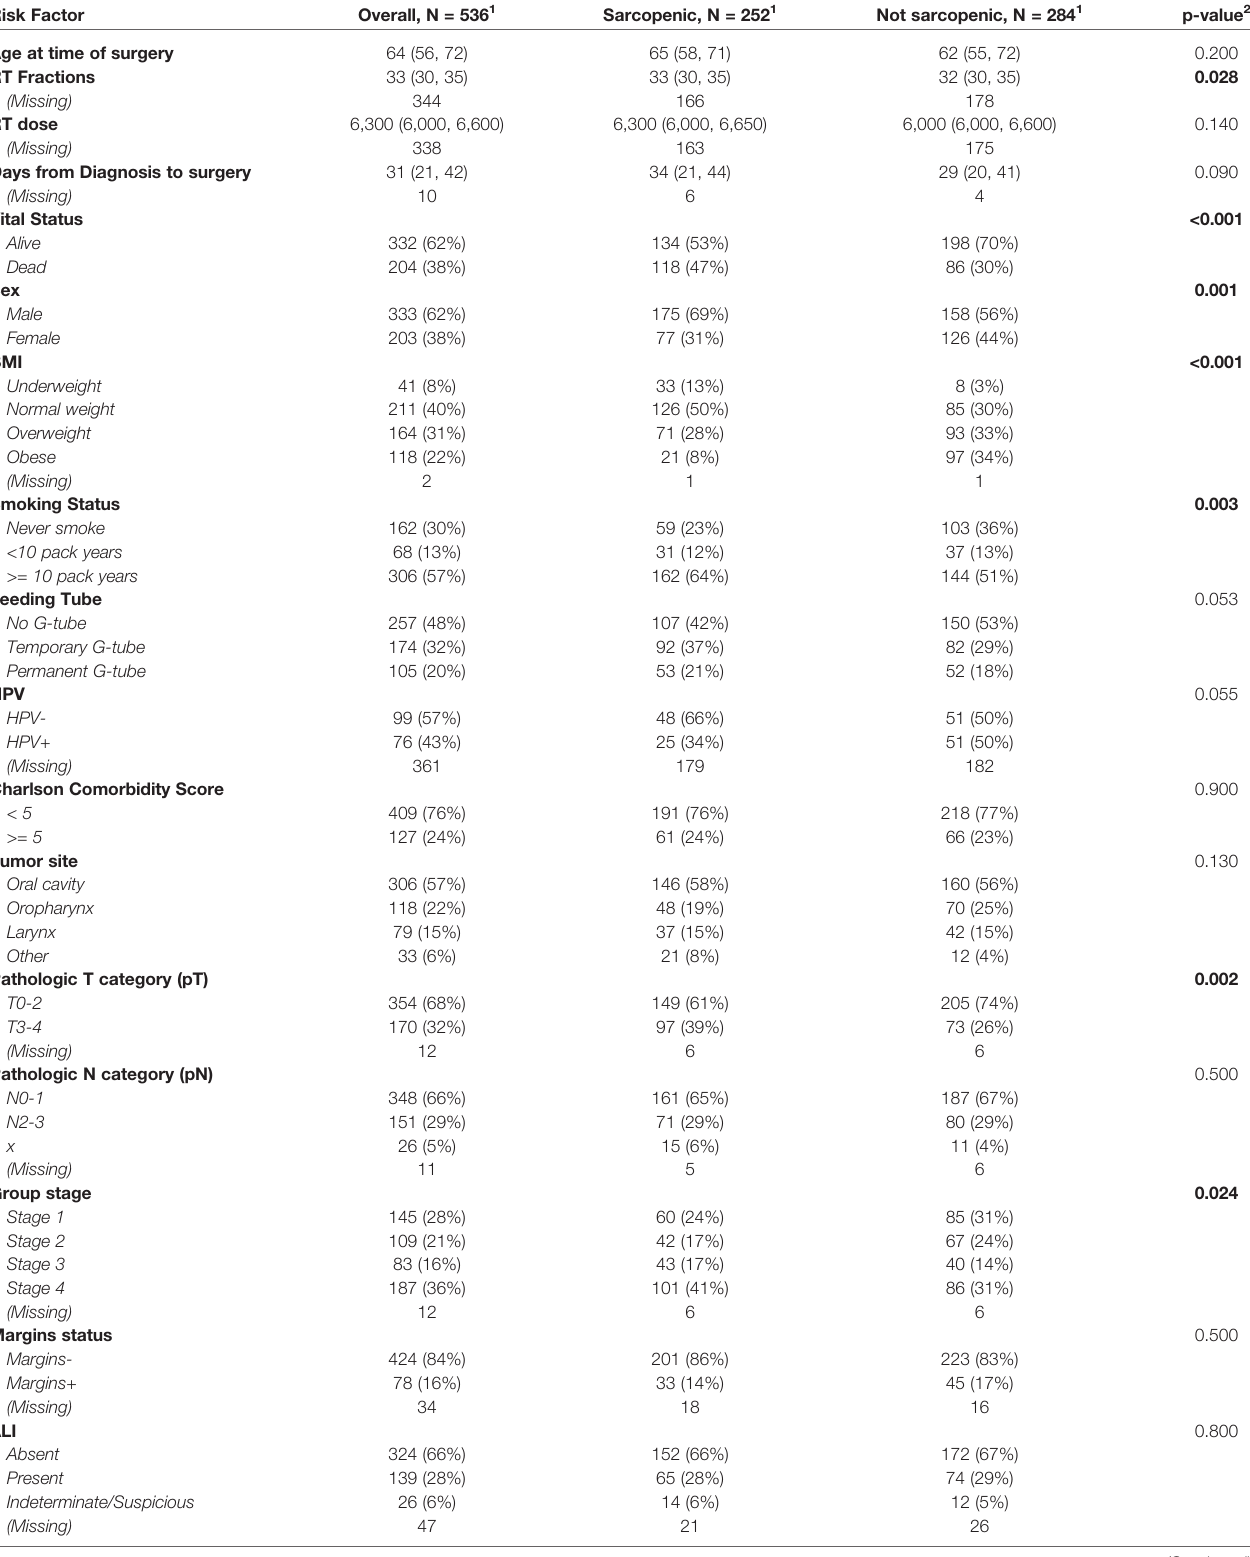
TABLE 1 | Clinical-demographic tables for validation set, strati fi ed by C3-de fi ned sarcopenia (Men: C3<14.0; Women: C3<11.1; n =